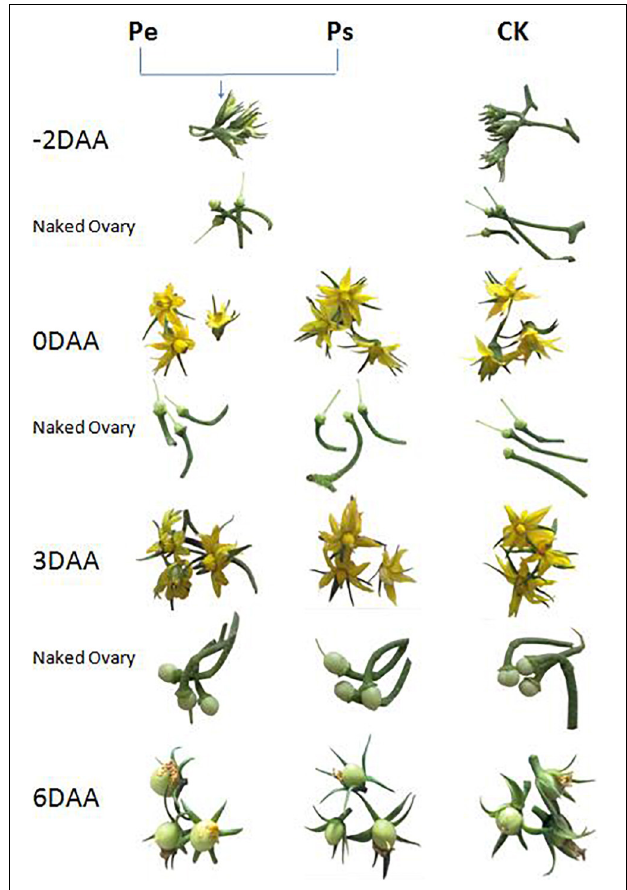
FIGURE 1 | Morphological changes of flowers and ovaries during the early development stages in Pe (stigma removed in “R35-P”), Ps (self-pollination in “R35-P”), and CK (self-pollination in